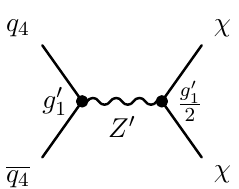
Figure 5 . The process responsible for DM production in the complete model in addition to those in figure